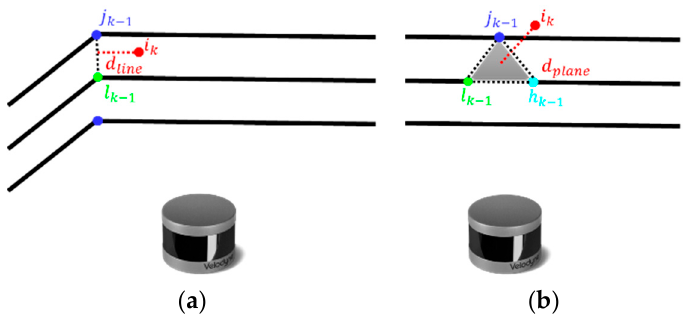
Figure 4. Geometric relationship for extracted features: ( a ) edge line for an edge point, ( b ) planar surface for a planar